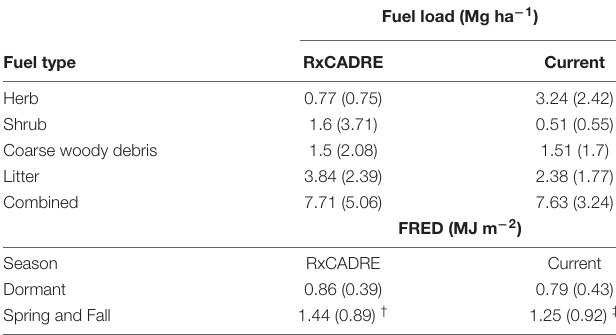
TABLE 9 | Comparison of fuel loads and FRED between RxCADRE study in sandhill longleaf woodland (Ottmar and Restaino, 2014) and the current study in upland longleaf woodland (means and standard